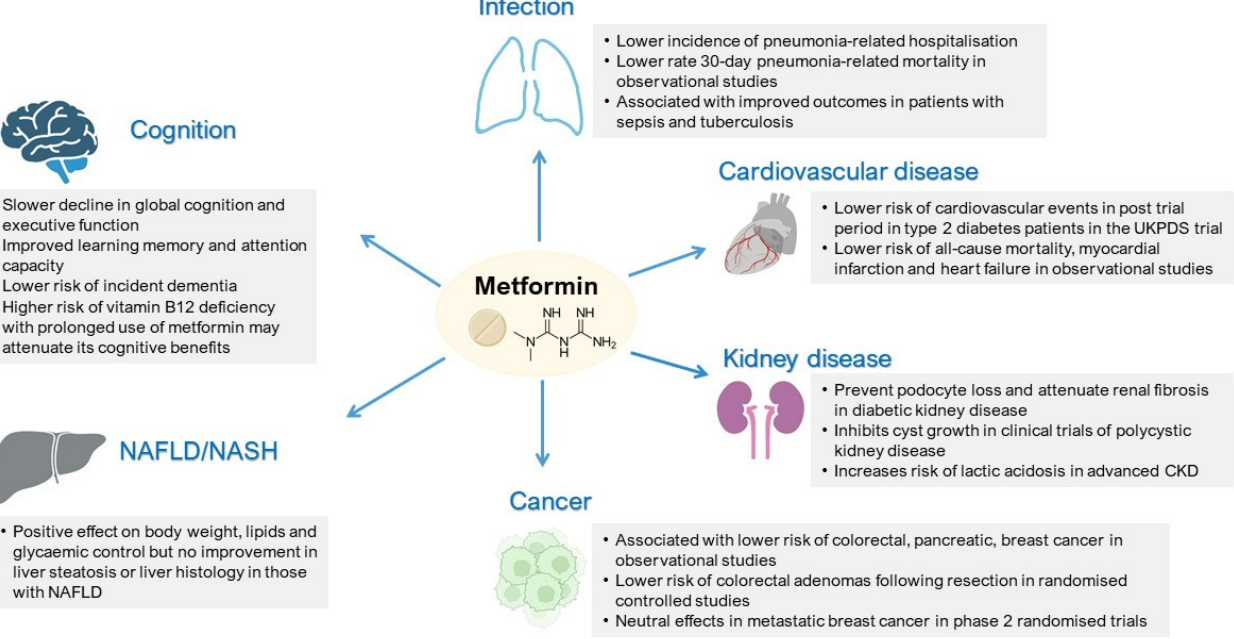
Figure 3. Summary of clinical effects of metformin in different disease conditions. NAFLD, Non- alcoholic fatty liver disease (NAFLD); NASH, non-alcoholic steatohepatitis; CKD, chronic kidney disease; and UKPDS, United Kingdom Prospective Diabetes Study.